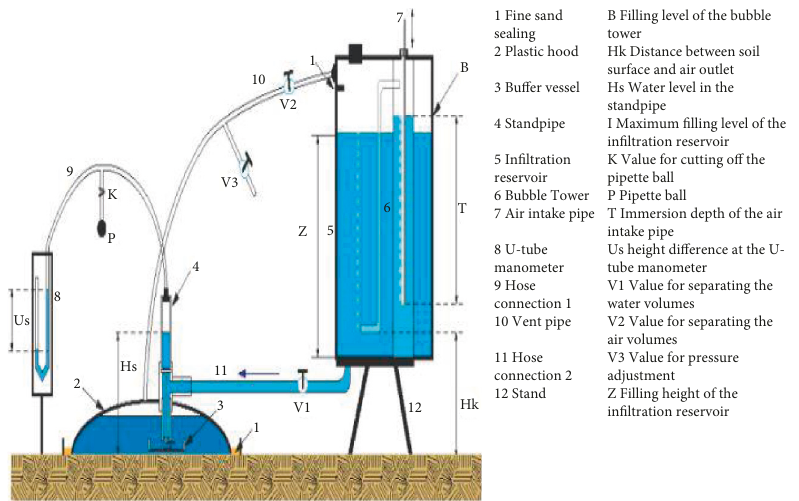
Figure 3: Hood infiltrometer